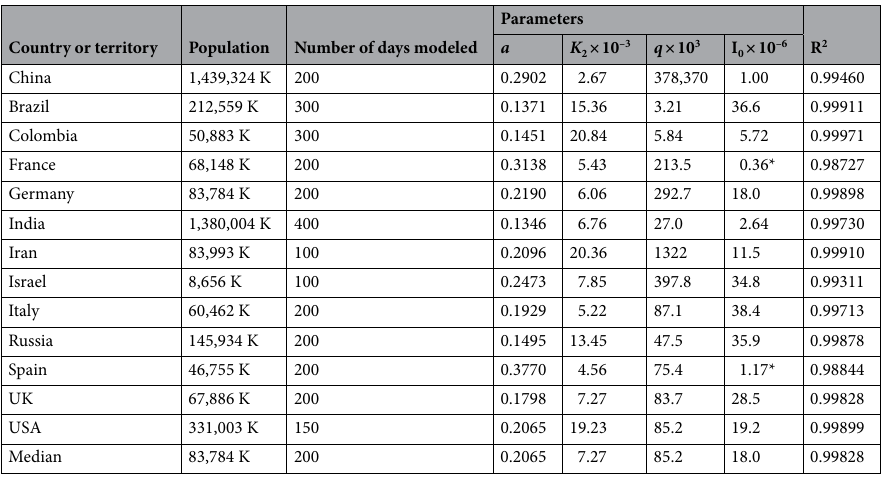
Table 1. Key epidemiological parameters used in simulation to explain the COVID-19 observations. *Unusually small I 0 for France and Spain may be caused by numerous data corrections in April’20–May’20.